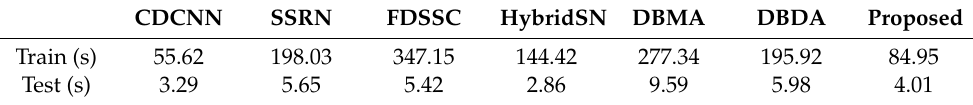
Table 11. The training time and test time in seconds (s) for different methods on the IP dataset. CDCNN SSRN DBDA Proposed